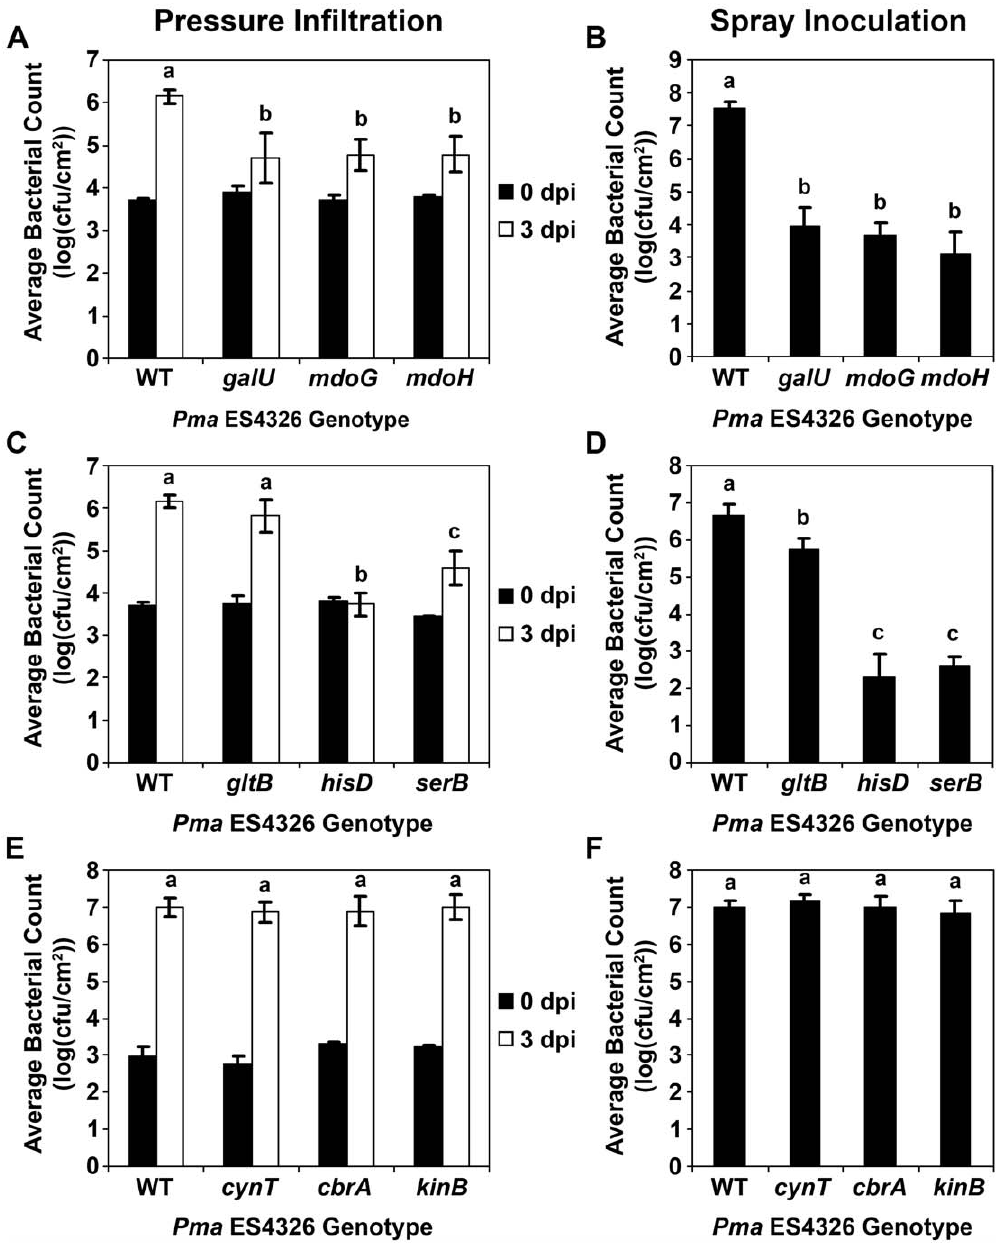
Figure 2. Inplanta growth of Pma ES4326 transposon disruptants in six-week-old soil-grown Arabidopsis plants, assessed by either pressure infiltration (A, C, E) or spray inoculation (B, D, F). Bacterial populations were quantified by dilution plating at zero and three days post-inoculation (dpi) for pressure infiltration and at three dpi for spray inoculation. With the exception of wildtype Pma ES4326 (WT), genotype names indicate the gene that is disrupted by a mini-Tn 5 transposon. Error bars reflect standard deviation of the mean of 10–12 replicate samples. Letters above data points indicate statistical significance groups as determined by pairwise Student’s t-tests ( a =0.05). At least two independent experiments were performed with similar